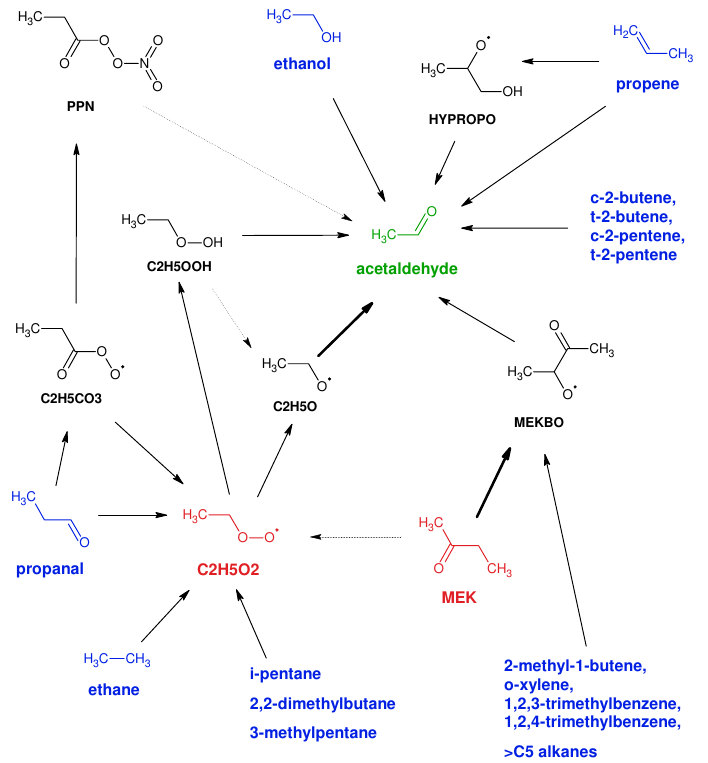
Fig. 10. Reaction scheme for the formation of acetaldehyde. Green indicates the target species, blue indicates the VOC precursors and red indicates an intermediate analyzed in detail in Sommariva et al.